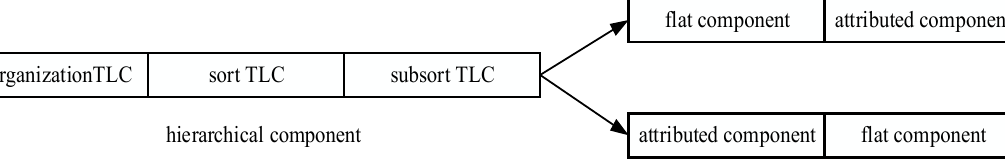
Figure 5. “Hierarchical component ‐ based” hybrid naming structure.